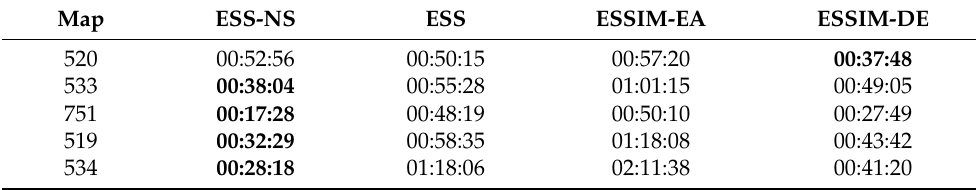
Table 4. Average execution times